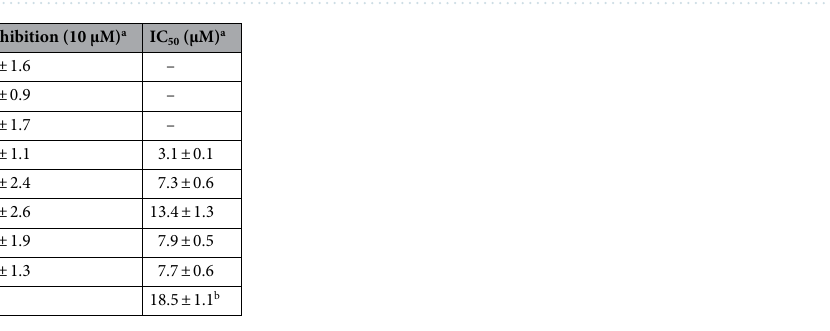
Table 3. α-Chymotrypsin inhibitory activity of Ugi adducts derived from plant products. a Data represent the mean ± SE of at least three independent experiments. b